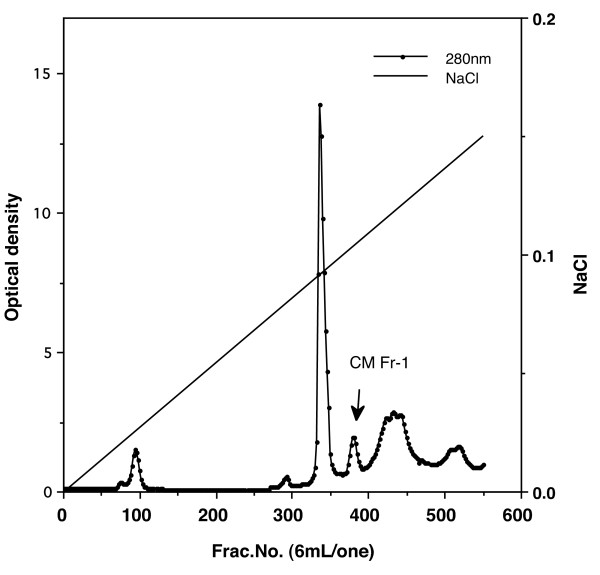
Chromatogram illustrating elution of proteins in muscle tissue extract from a healthy chicken from a carboxymethyl cellulose column (3.4 × 30 cm) with a 0 M to 0.05 M NaCl gradient. The total volume of the gradient was 2,500 mL. Optical density of each fraction was determined at 280 nm. The fourth peak (CM-Fr 1) of the CM-cellulose chromatography column contained CA activity.